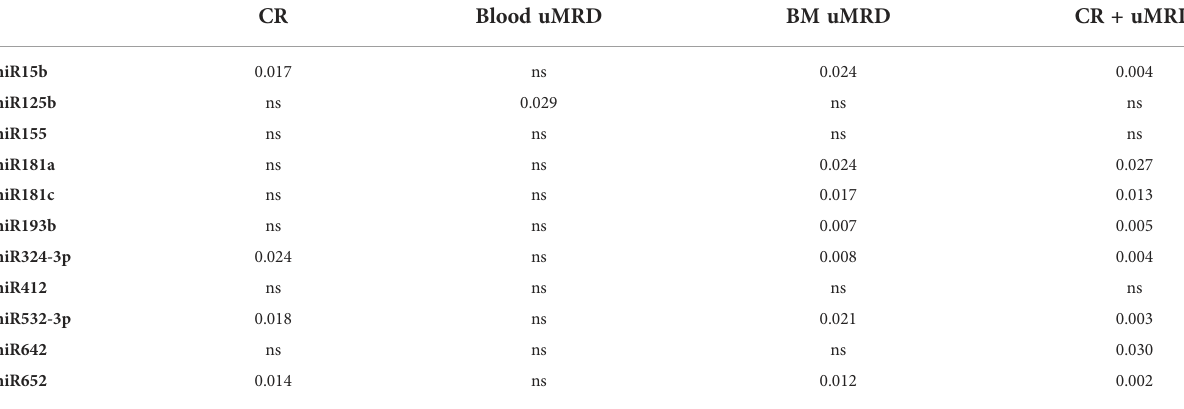
TABLE 3 Univariate miRNA analyses in B-CLL patients according to treatment response using the IWCLL 2008 guidelines and uMRD.